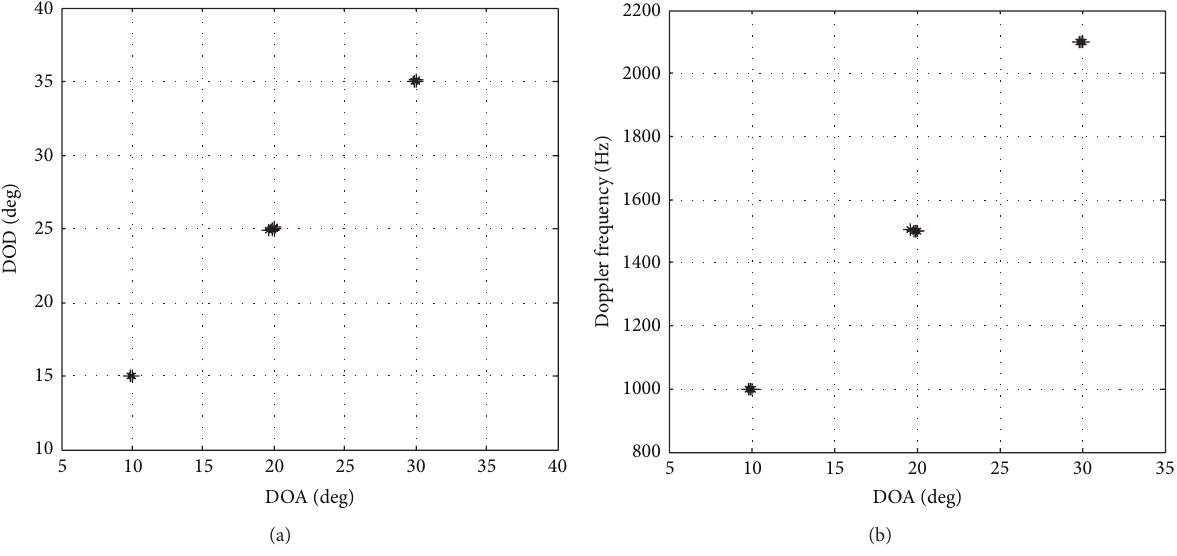
Figure 2: Angle and Doppler frequency estimation at SNR =